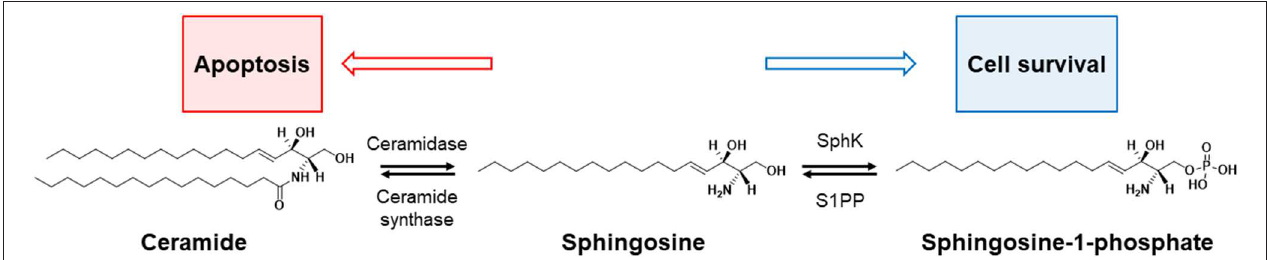
FIGURE 3 | Rheostat of sphinglipid. The balance between cell survival and death (apoptosis) in sphingolipids is controlled by four enzymes: sphingosine kinase (SphK), sphingosine-1-phosphate phosphatase (S1PP), ceramidase, and ceramide synthase. The increase in ceramide turns up the rheostat toward apoptosis, and the increase in apoptotic precursors [e.g., sphingosine-1-phosphate (S1P)] toward cell survival. as the sphingolipid rheostat, and this concept is illustrated in Figure 3